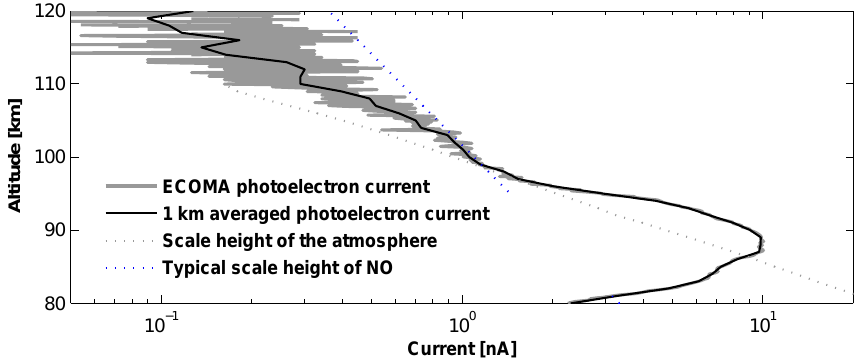
Fig. 5. The photoelectron measurement by the ECOMA detector on the ascent part of the flight. The solid grey profile is the complete data while the solid black line is the 1km interval averaged data. The dotted grey and blue lines show the decrease of the neutral atmo- sphere and NO densities with increasing altitude indicating their scale heights of ∼ 5km and ∼ 18km, respectively. Photoelectrons from the photoionization of NO are thought to dominate the signal above ∼ 95km, i.e. above the main meteoric smoke particle layer.